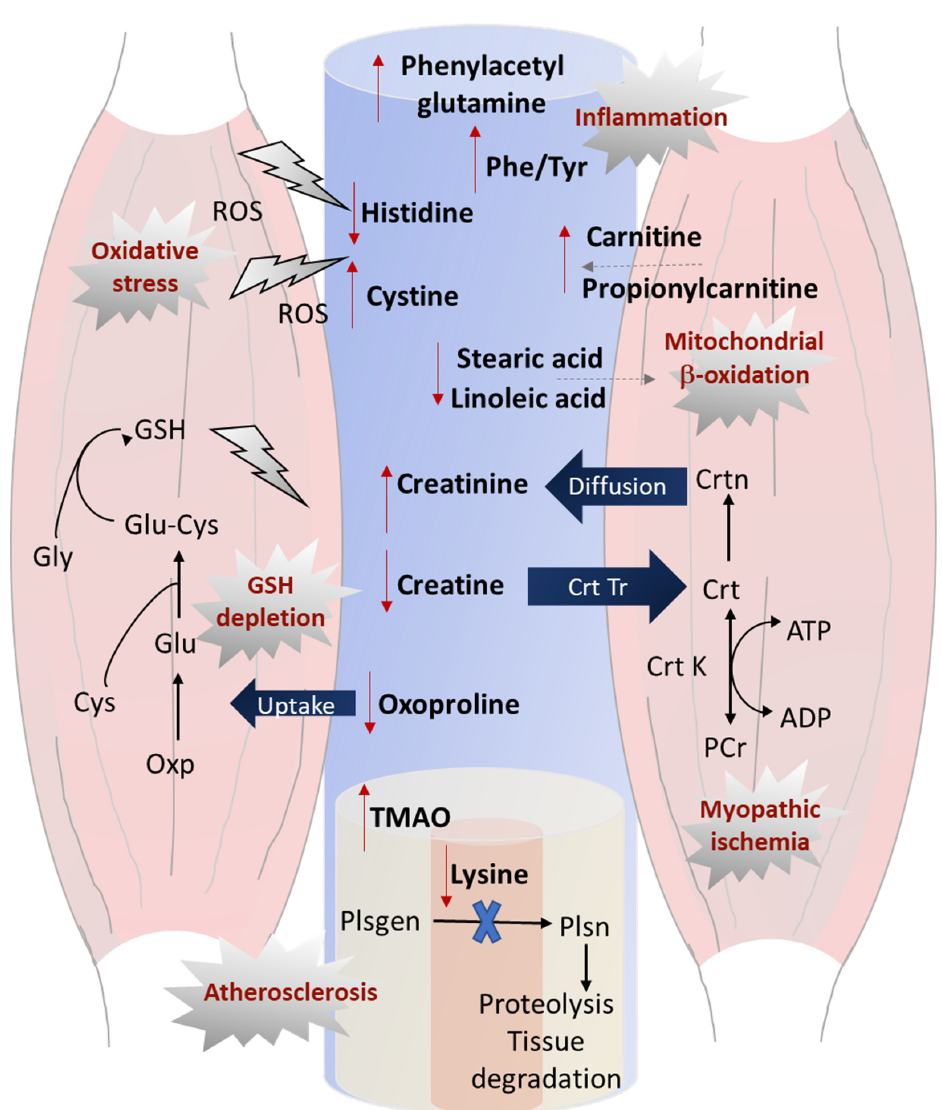
Figure 6. Schematic illustrating the systemic e ff ects of an aberrant circulatory metabolism reflecting PAD progression in serum that also reflects the localized ischemia of skeletal muscle in lower limbs. Reduced serum lysine, an inhibitor of plasmin activation, in pathological states, leads to excessive proteolysis and vascular tissue degradation that is exacerbated by elevated TMAO, further promoting atherosclerosis in CLTI. Serum oxoproline, a key precursor used in the glutathione (GSH) salvage pathway, decreases in circulation as it is transported within the muscle to support intracellular glutathione recycling in response to elevated oxidative stress as reflected by lower histidine, and higher cystine in serum. Reduced creatine availability leads to lower intramuscular phosphocreatine, attributing to myopathic ischemia and perturbed energy homeostasis within the muscle that coincides with elevated creatinine concentrations in serum for CLTI. Impaired mitochondrial beta ‐ oxidation is reflected by higher circulating carnitine and propionylcarnitine, that are not stored within ischemic muscle tissue in conjunction with lower circulating lipids/fatty acids, such as stearic acid and linoleic acid. Lastly, increased serum phenylacetylglutamine and Phe/Tyr reflect increased inflammation in CLTI, which are risk factors for all ‐ causes mortality and cardiovascular disease. Abbreviations correspond to ROS: reactive oxygen species, ADP: adenosine diphosphate, ATP: adenosine triphosphate, Crt K: creatine kinase, Crt Tr: creatine transporter, Plsgen: plasminogen, Plsn: plasmin.